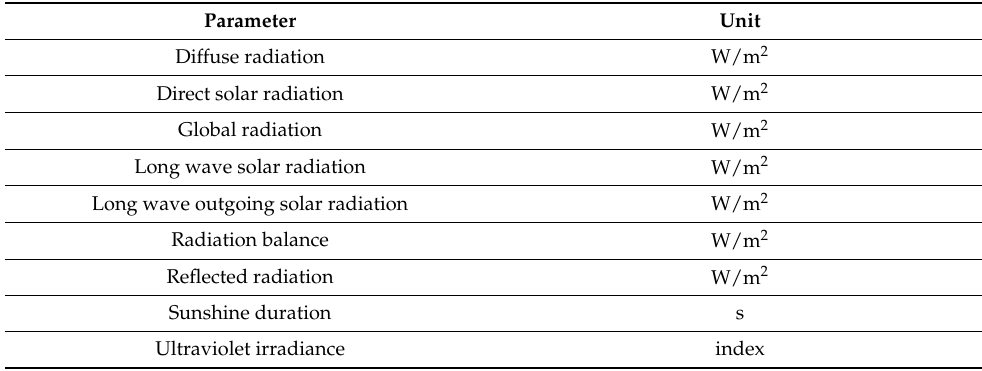
Figure 5. Aggregated FCR-N capacity of the photovoltaic panels at the shopping center. Table 3. Solar Radiation features provided by open